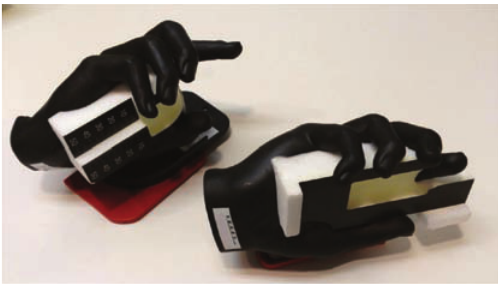
F 3: Examples of phantom hand models.